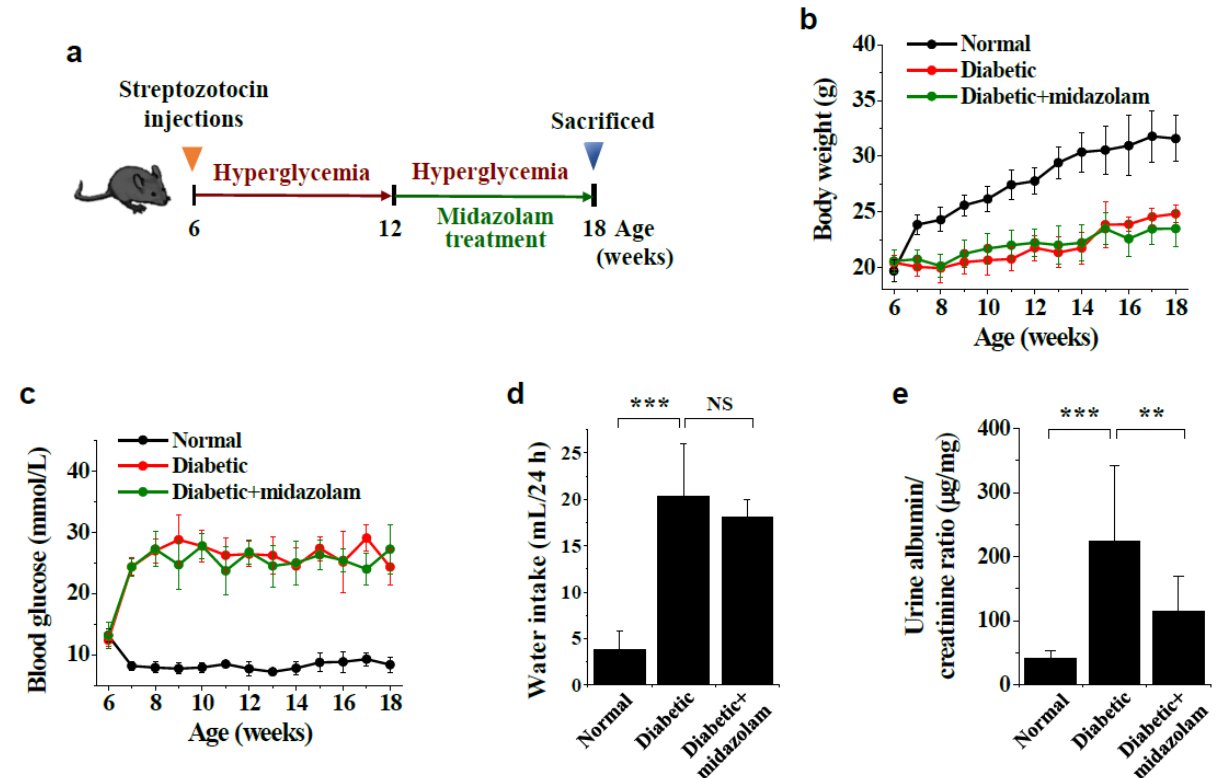
Figure 1. Biochemical parameters of normal, diabetic, and midazolam-treated diabetic mice. Diabetes was induced in 6-week-old male C57BL/6 mice by intraperitoneal injection of streptozotocin (50 mg/kg body weight) for 5 consecutive days. Six weeks after streptozotocin injection, diabetic mice were treated with midazolam (10 mg/kg per mouse) by subcutaneous injection to the nape of the neck every 3 days for 6 weeks. ( a ): Schematic overview of diabetic mouse model and midazolam treatment regimen. ( b ) and ( c ): Body weight ( b ) and blood glucose levels ( c ) were monitored weekly ( n = 8). ( d ) and ( e ): After 6 weeks of midazolam treatment, water intake (mL/24 h) ( d ) and urine albumin/creatinine ratios ( e ) were measured ( n = 8). ** p < 0.01, *** p < 0.001; NS, non-significant.